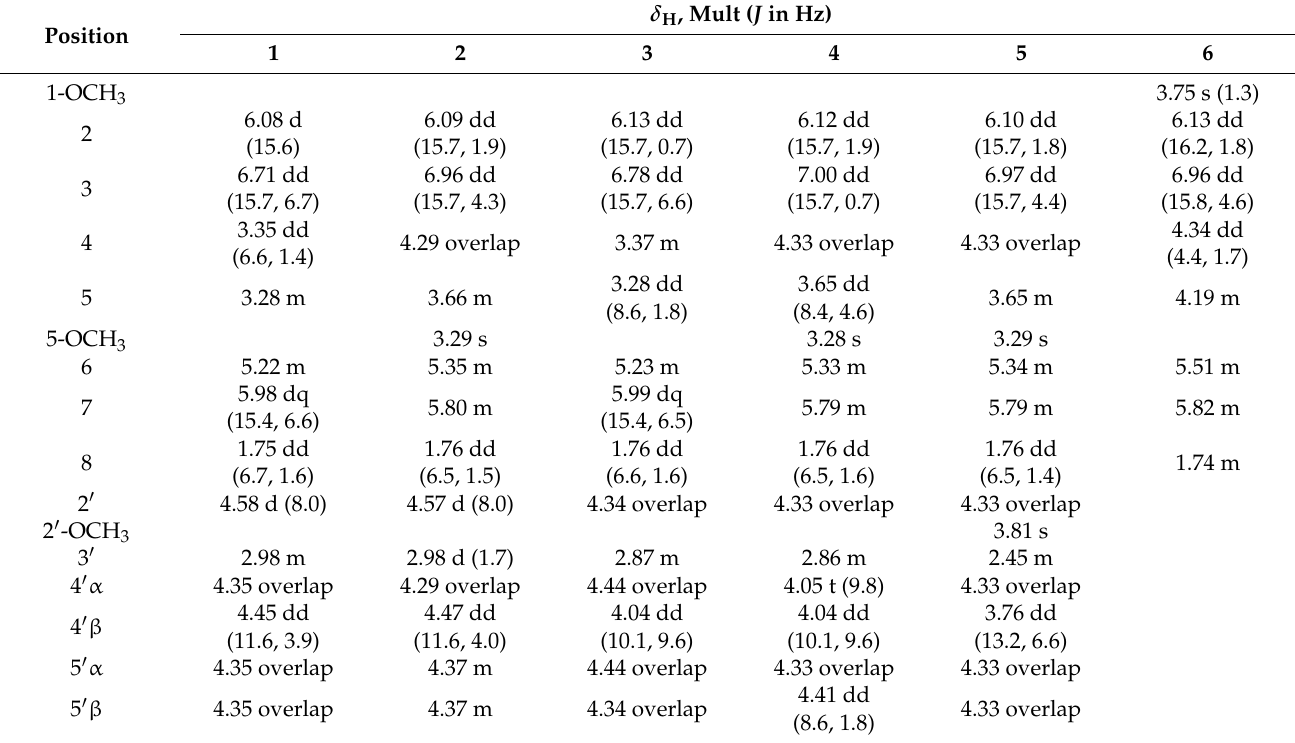
Table 1. 1 H (600 MHz) NMR data of compounds 1 – 6 in CDCl 3